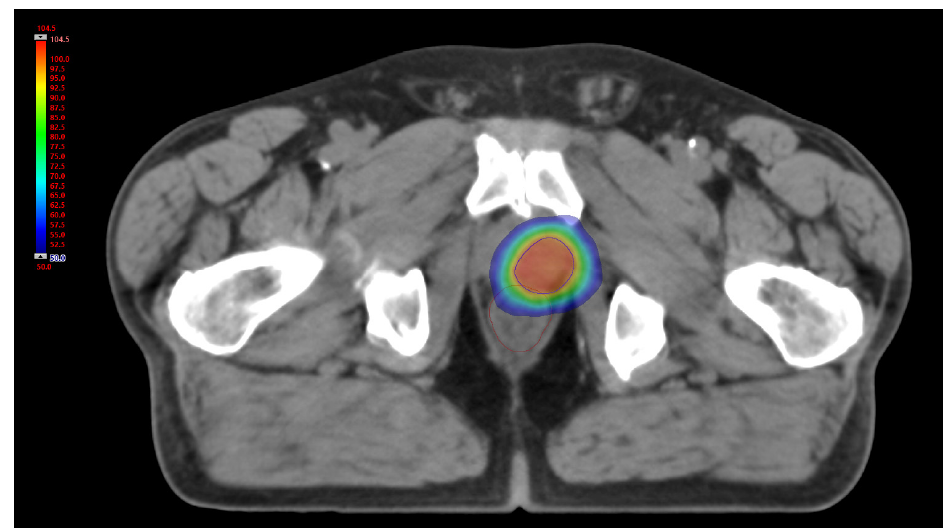
Figure 2. Axial view of 3D relative dose distribution (%). Blue line: PTV; brown line: rectum. Table 1. Characteristics of patient